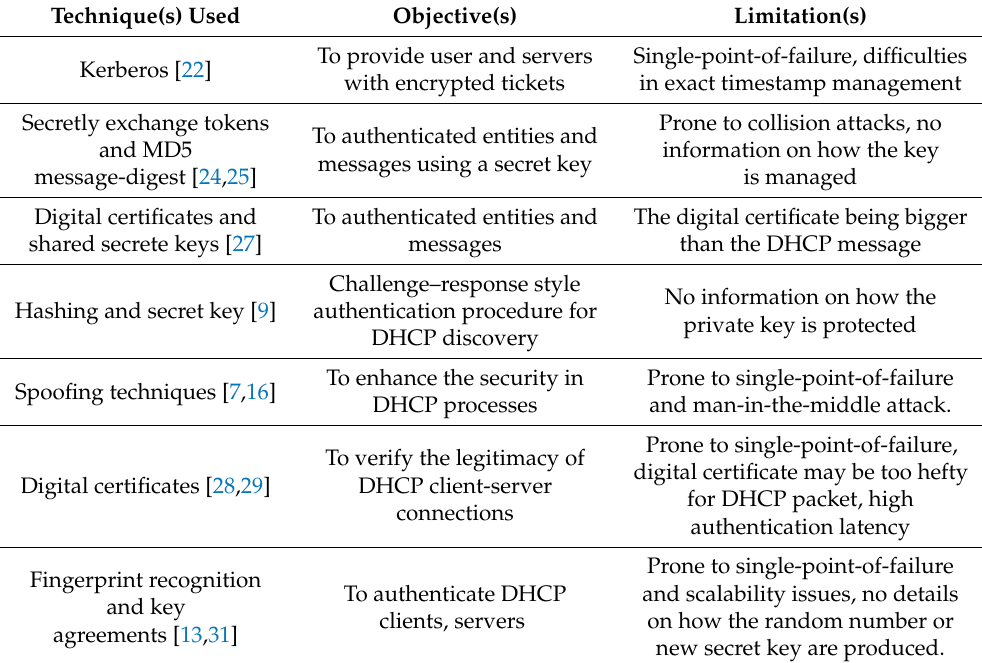
Table 1. An overview of the related